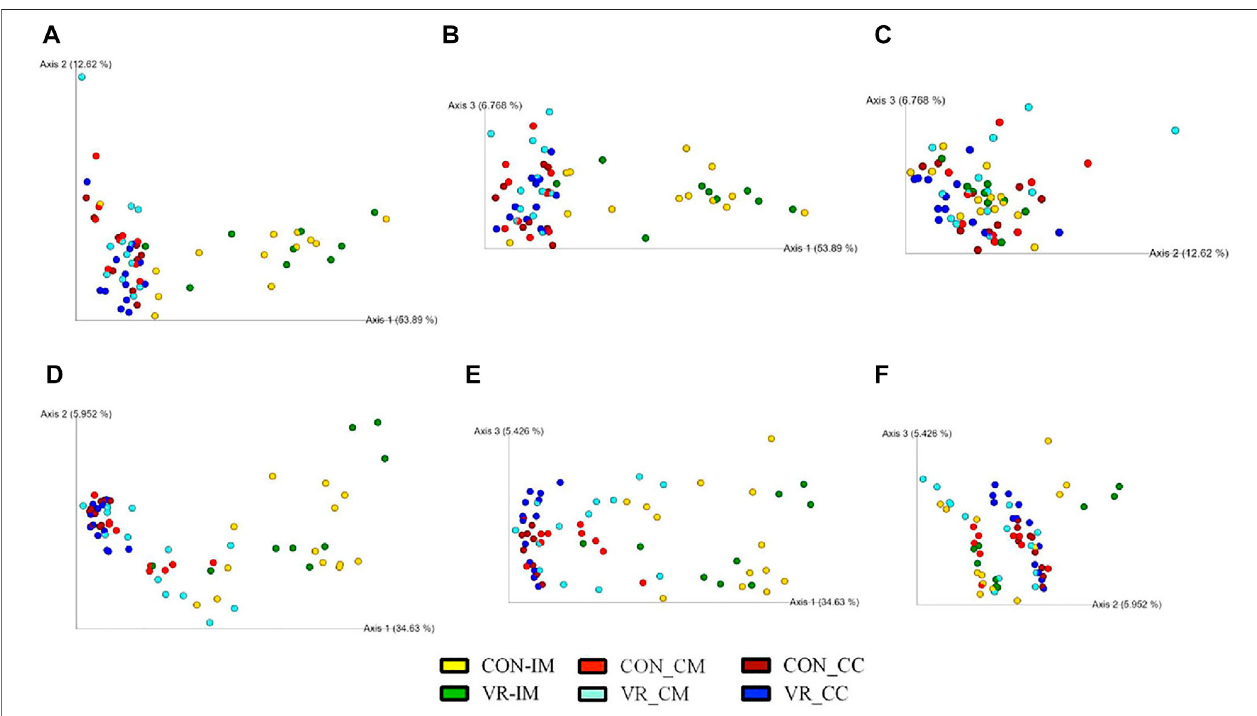
FIGURE5| BetadiversityplotsofcecamicrobiomefromCONandVRbirds( n =15/group)viaweightedUniFrac (A – C) andunweightedUniFrac (D – F) PCoAplots. Each sphere represents intestinal site from an individual bird, colored per respective group. Figures were generated by QIIME2 software. Yellow, CON ileum mucus. Green, VR ileum mucus. Bright red, CON ceca mucus. Bright blue, VR ceca mucus. Dark red, CON ceca content. Dark blue, VR ceca